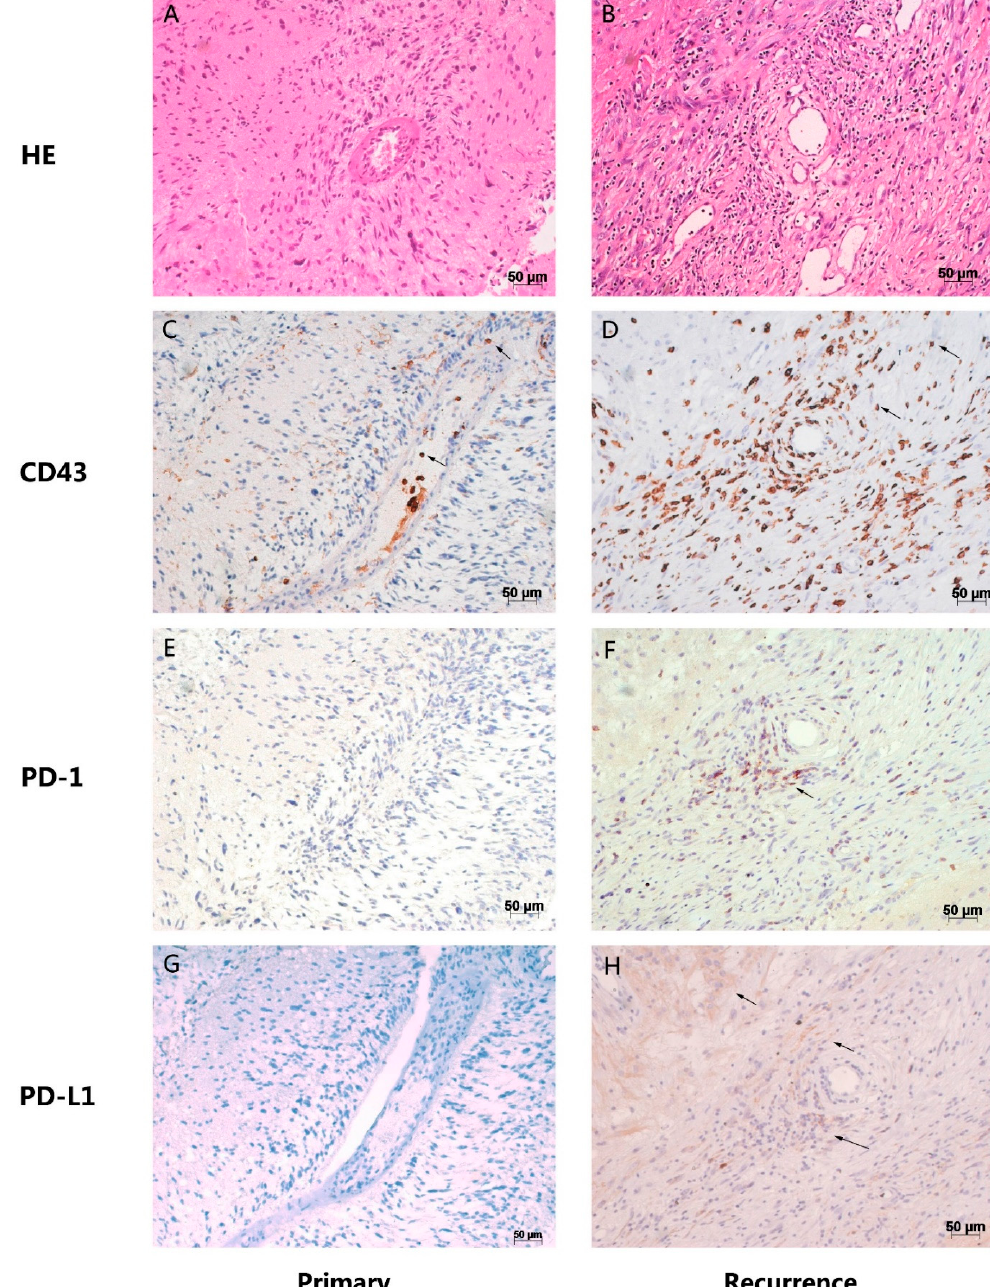
Figure 6. PD-1 and PD-L1 expression in the same location in a primary tumor and its corresponding recurrent glioma in one of the glioma patients. ( A ) HE staining for primary glioma. ( B ) HE stained for the corresponding recurrent glioma. ( C ) CD43 immumohistochemical staining for the serial section of primary glioma. ( D ) CD43 immumohistochemical staining for the serial section of the corresponding recurrent glioma. ( E ) PD-1 immumohistochemical staining for the serial section of primary glioma. ( F ) PD-1 immumohistochemical staining for the serial section of the corresponding recurrent glioma. ( G ) PD-L1 immumohistochemical staining for the serial section of primary glioma. ( H ) PD-L1 immumohistochemical staining for the serial section of the corresponding recurrent glioma. The patient was diagnosed as glioma grade III, negative for both PD-1 and PD-L1 after the first operation in 2011; when recurrence occurred, the histological diagnosis progressed to glioblastoma with positive PD-1 and PD-L1. PD-1 was expressed in lymphocytes ( CD43 labeled), and PD-L1 was expressed in tumor cells near these